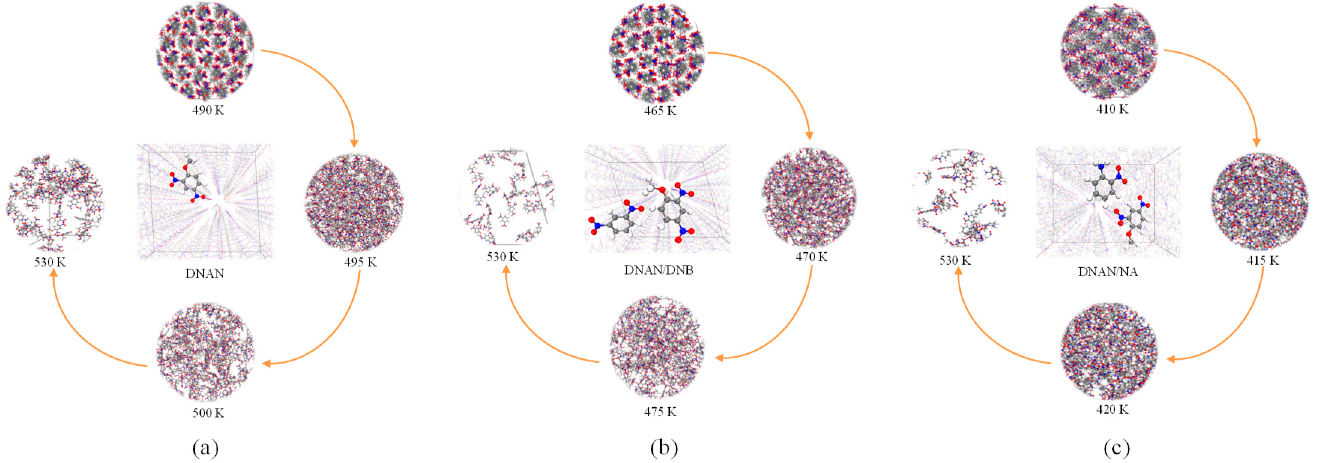
Figure 9. Snapshots of the melting processes of DNAN ( a ), DNAN/DNB ( b ), and DNAN/NA ( c ). Each perspective view in the middle denotes the representative molecular structure of each crystal.